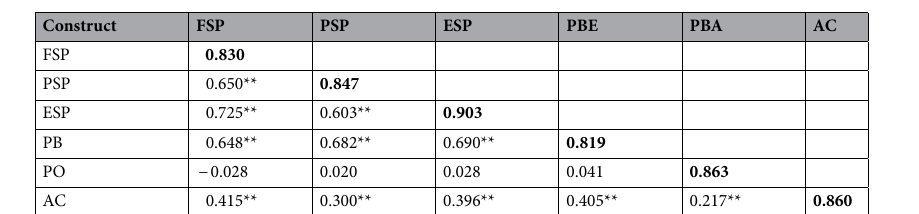
Table 4. Discriminant validity test. The boldface values on the diagonal are the AVE square-root values, and the other values represent between-plane correlation coefficients. N = 228; ** p < 0. 01 for the two-tailed test. Data sources: Calculation and arrangement of this